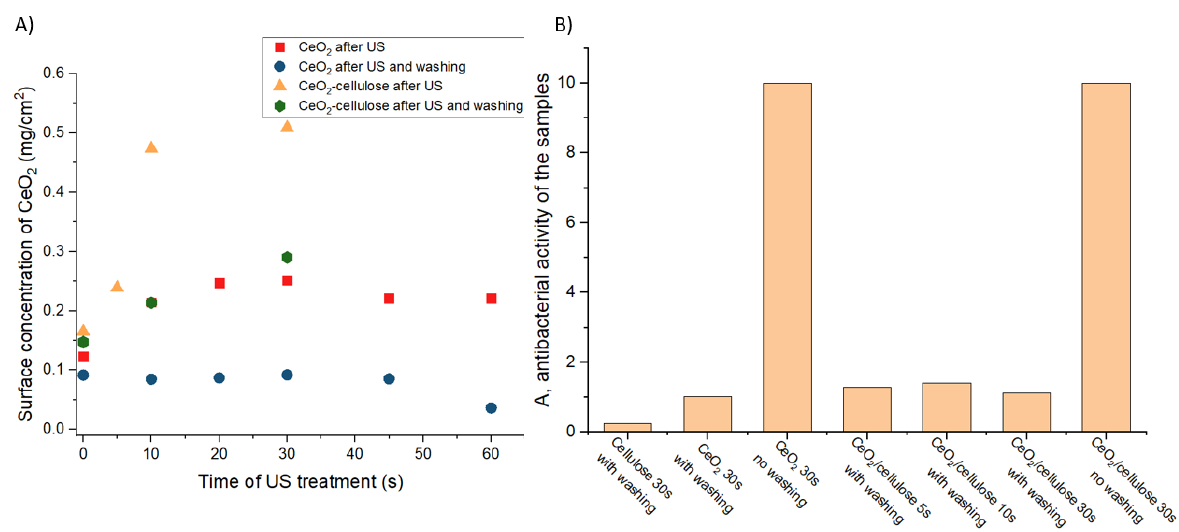
Figure 5. ( A ) The dependence of the CeO 2 concentration on the surface of the cotton fabric on ultrasonic treatment time. ( B ) Antibacterial activity of the samples. ( B ) Antibacterial activity of the